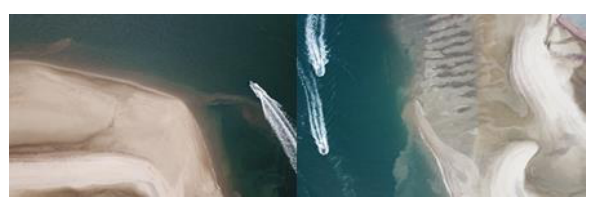
Figure 7. Sample images of dataset in Taean, South